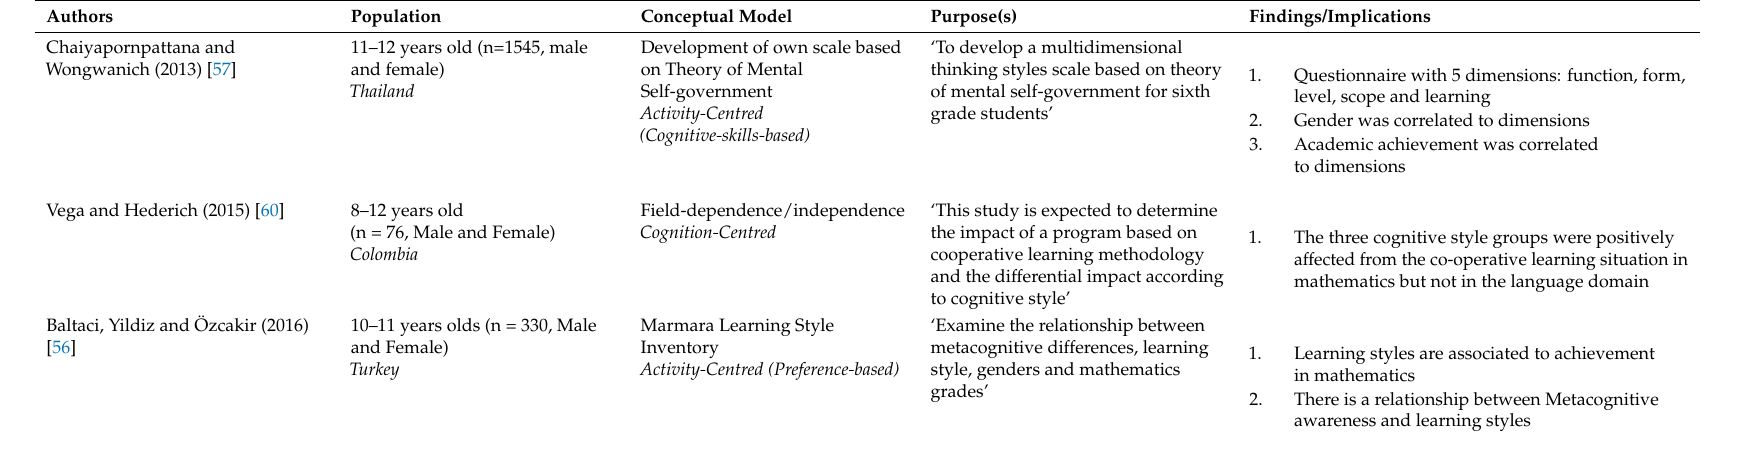
Table A1. Key Summary of